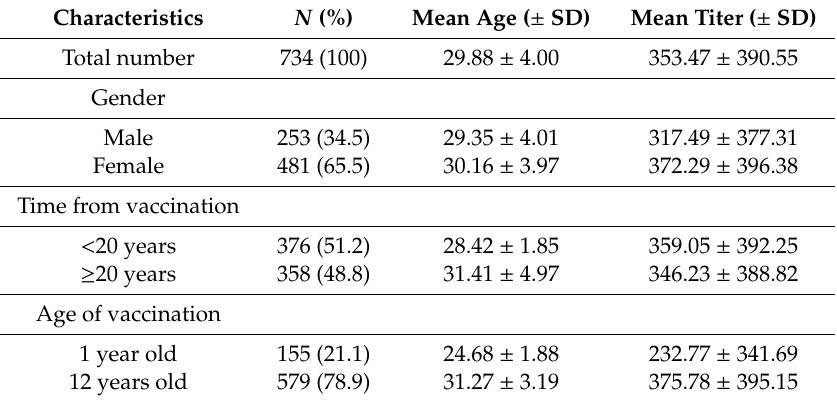
Table 1. Demographic characteristics of healthcare workers ( n =